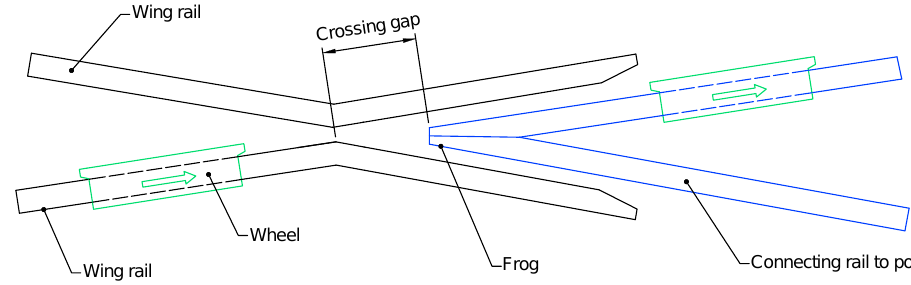
Figure 2. Usual configuration of a crossing.